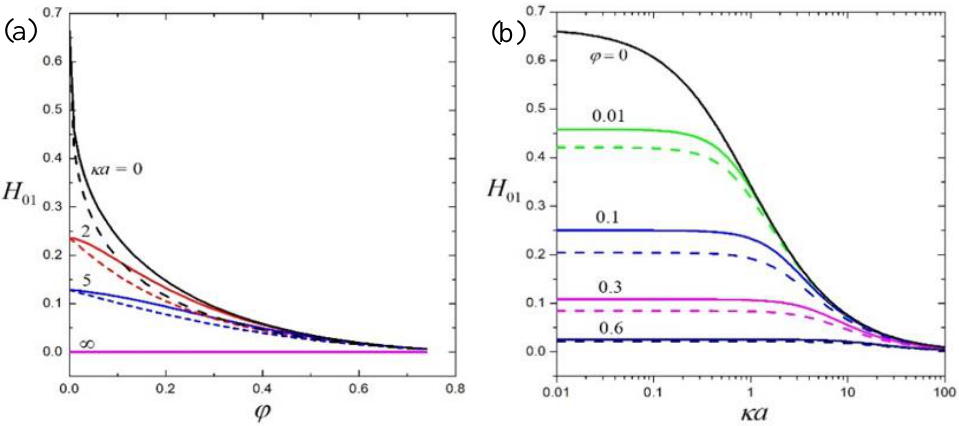
Figure 2. The electrophoretic mobility coe ffi cient H 01 for a suspension of hard spheres versus the parameters ( a ) ϕ and ( b ) κ a . The solid and dashed curves represent the calculations for the Happel and Kuwabara models, respectively, and H 01 = 2/3 in the particular case of ϕ = 0 and κ a = 0. The results for the chemiphoretic mobility coe ffi cient H 02 of a suspension of hard spheres with constant surface charge density σ are plotted versus the parameters κ a and ϕ in Figure 3. The value of H 02 is always positive (the chemiphoresis is directed along the electrolyte concentration gradient) and not necessary a monotonic function of ϕ or κ a , keeping the other unchanged. For a given value of κ a , the value of H 02 first increases with an increase in ϕ from a constant at ϕ = 0, reaches a maximum, and then decreases with a further increase in ϕ ; the particle interaction e ff ect on the chemiphoretic mobility − 4 can also be significant. For relatively concentrated suspensions (say, ϕ ≥ 10 ), H 02 is a monotonic decreasing function of κ a from a constant at κ a = 0 to zero as κ a → ∞ . For the particular case of ϕ = 0, the value of H 02 first increases with an increase in κ a from zero at κ a = 0, reaches a maximum, and then decreases with a further increase in κ a to zero as κ a → ∞ . The Happel model also predicts a slightly greater value for the chemiphoretic velocity than the Kuwabara model